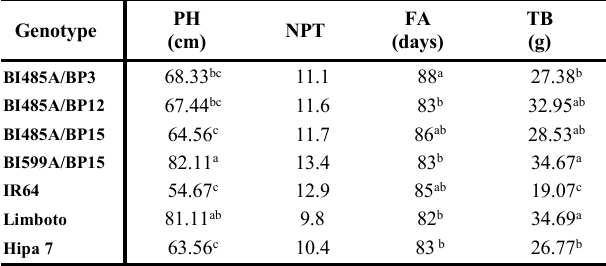
Table 5: Growth components including plant height (PH), number of productive tillers (NPT), flowering age (FA), and total biomass (TB) of hybrid rice genotypes and check varieties in rain-fed lowland.